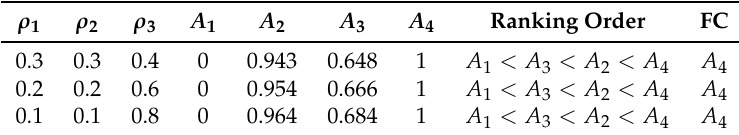
Table 11. Middle risk lover.